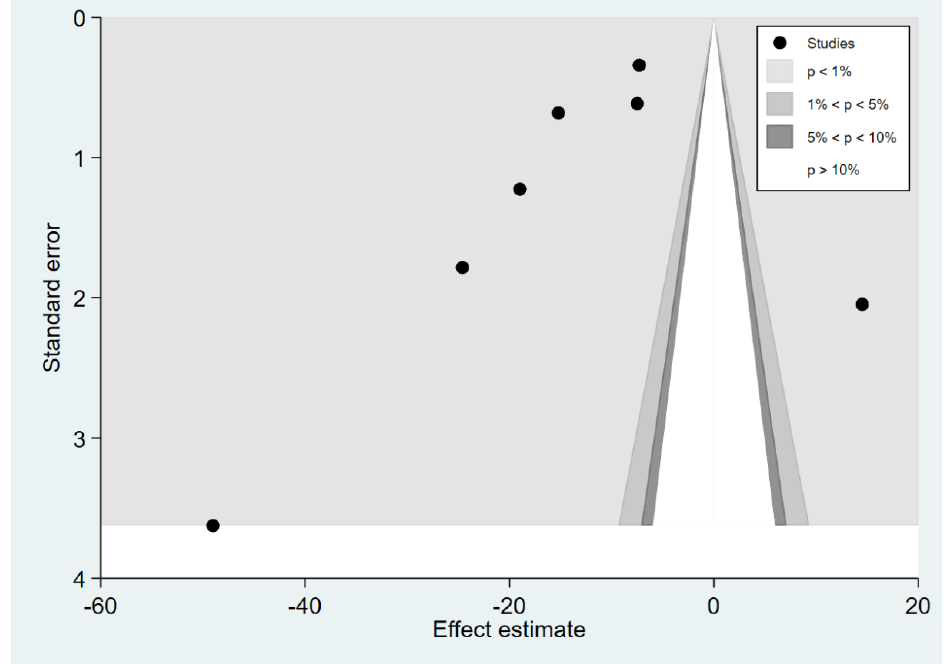
Figure 9. Contour-enhanced funnel plot demonstrating the MD in TGF-β levels between uncomplicated malaria and healthy controls (pg/mL) in the significant area (pale grey area), indicating that the cause of funnel plot asymmetry was the publication bias.